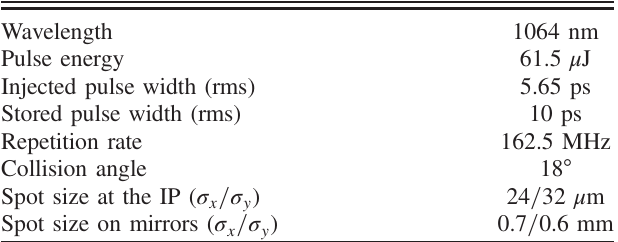
TABLE II. Parameters of the laser in the optical cavity at the LCS experiment.